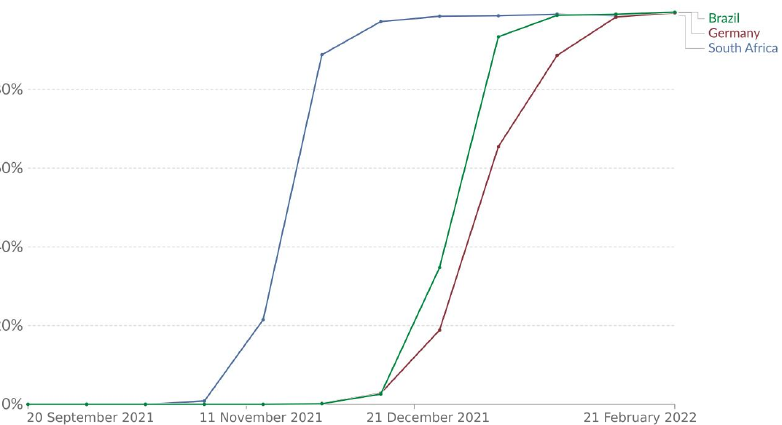
Figure 3. Percentage of Omicron variant of all analysed sequences. This figure was adapted from the one generated by Our World in Data